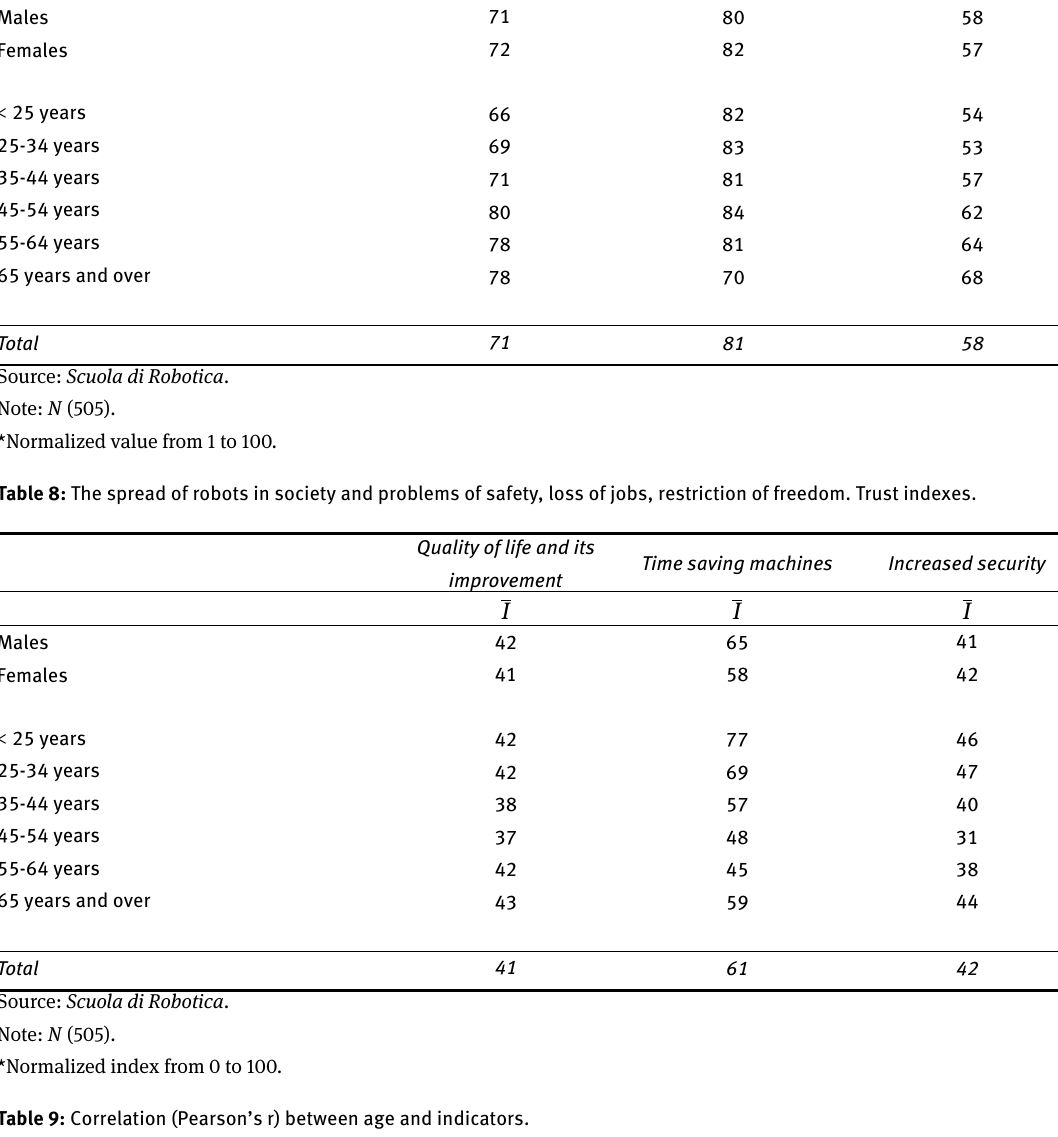
Table 9: Correlation (Pearson’s r) between age and indicators. Quality of life